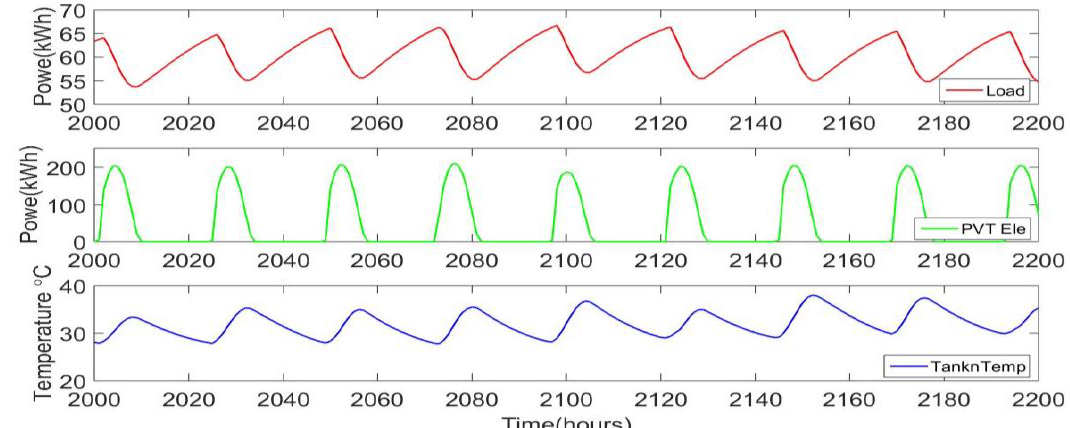
Int. J. Environ. Res. Public Health 2021 , 18 , x FOR PEER REVIEW Figure 5. Total system electrical load, PVT electrical output, and tank temperature (bottom).